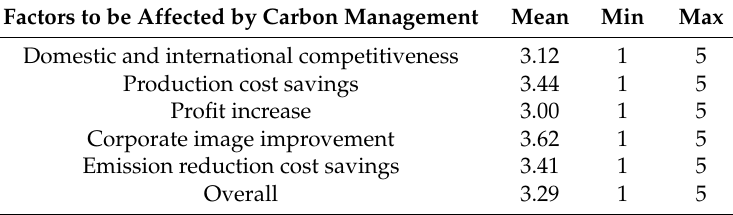
Table 10. Factors to be affected by CMAs ( n = 99).